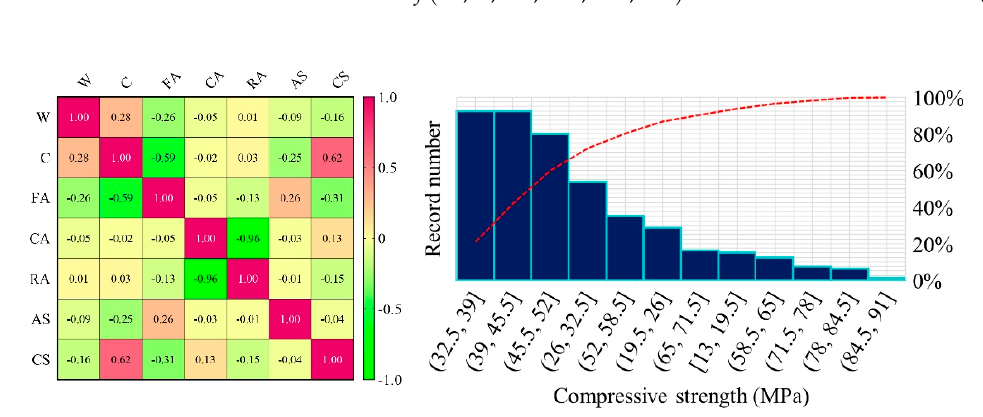
Figure 2. Variable analysis of inputs and output.